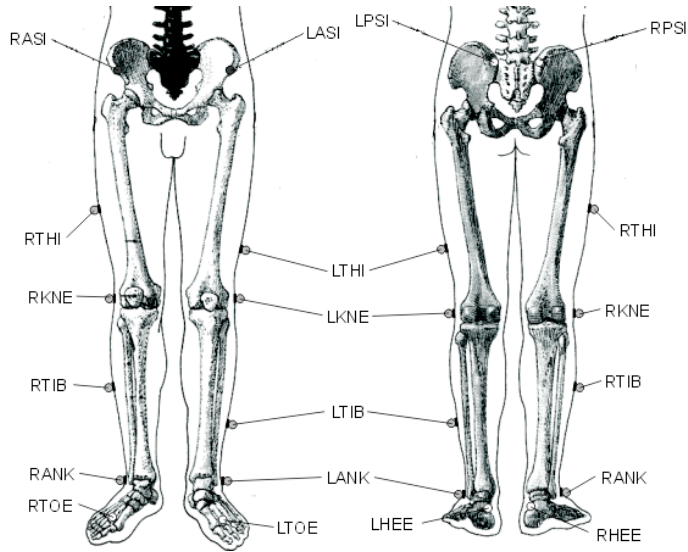
Figure 3. Reflective marker placement according to the Plug-In-Gait lower limbs model.